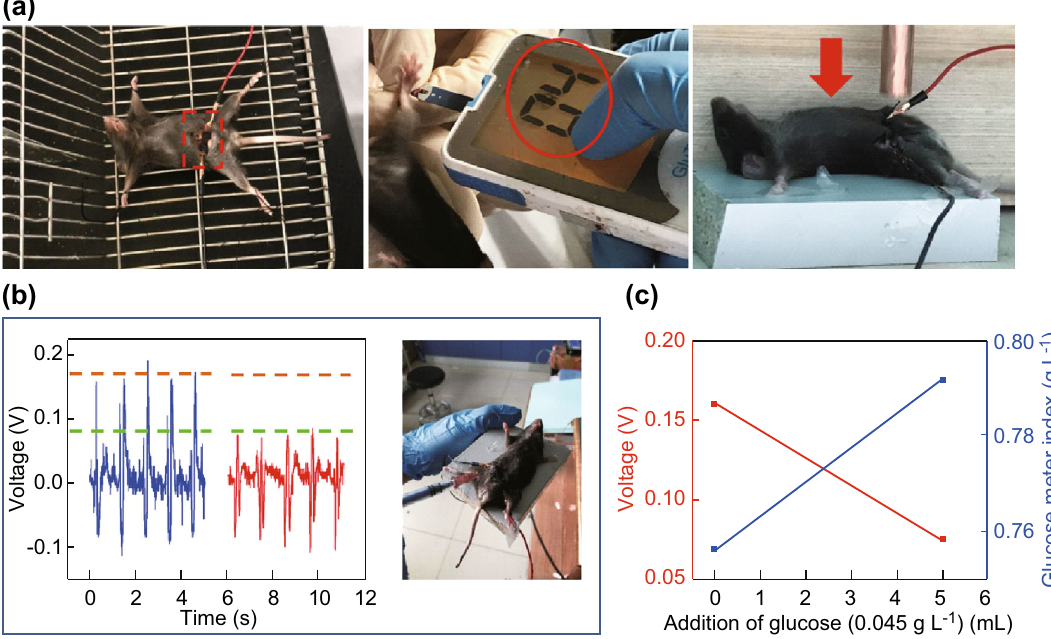
Fig. 6 Practical application of self-powered implantable skin-like glucometer implanted in a mouse body for detecting blood glucose concentration without any external electricity power source. a Implanting the device into the mouse and measurement set. b The outputting piezoelectric voltage changes before and after injection of glucose solution. c The outputting piezoelectric voltage and glucose meter index of the device before and after the injection of glucose